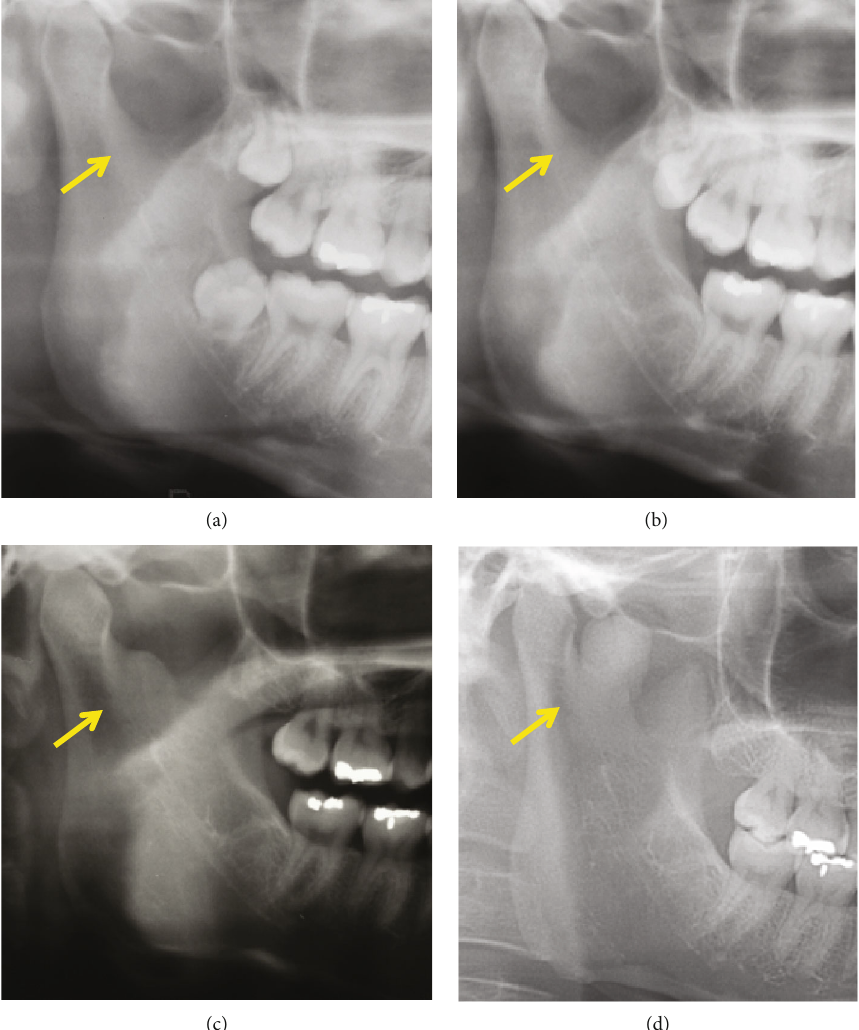
Figure 1: Time course of osteoma in the right mandibular notch by panoramic radiography. (a) At the age of 18, no osteoma was found in the right mandibular notch. (b) At the age of 21, no osteoma was found in the right mandibular notch. (c) At the age of 26, a bony bulge was found in the right mandibular notch. (d) At the age of 38, an oval radiodense mass was observed in the right mandibular